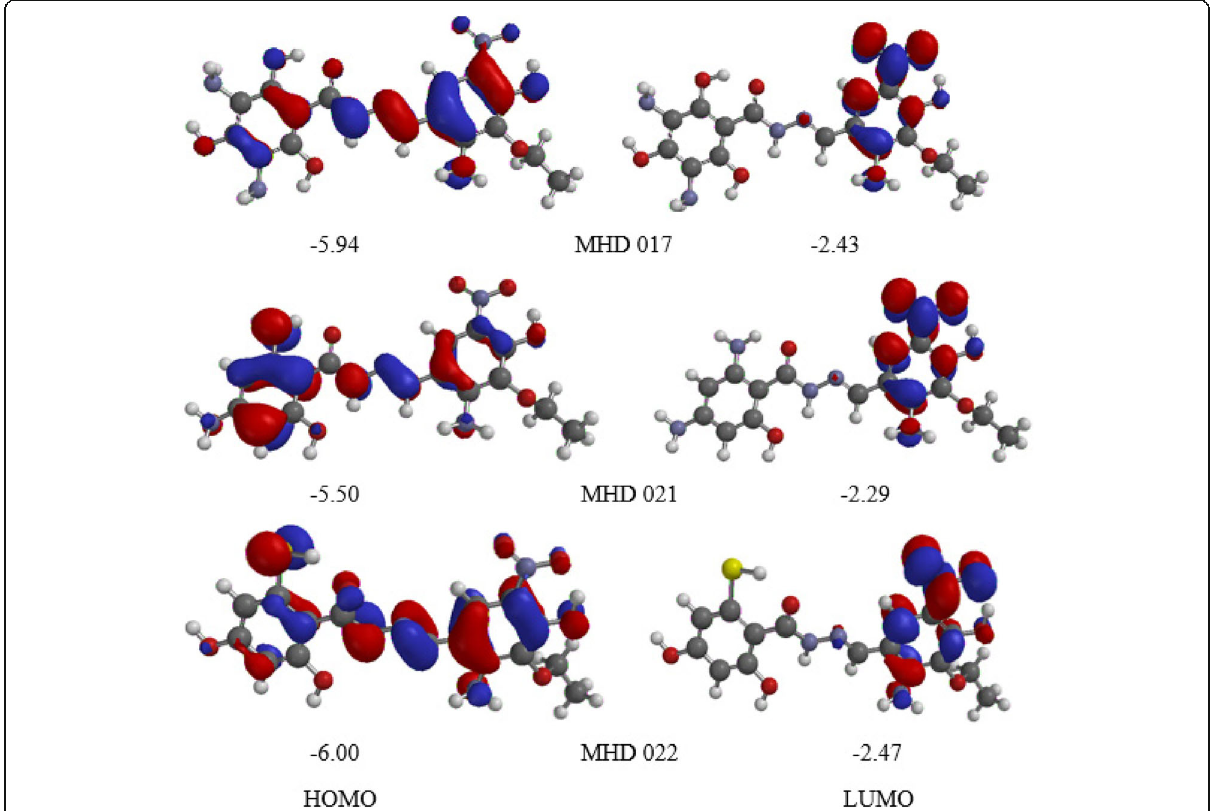
Fig. 3 The orbital distribution and energy (in eV) of HOMO and LUMO for MHD 017, MHD 021 and MHD 022 computed at the B3LYP/6-311G* level in the gas